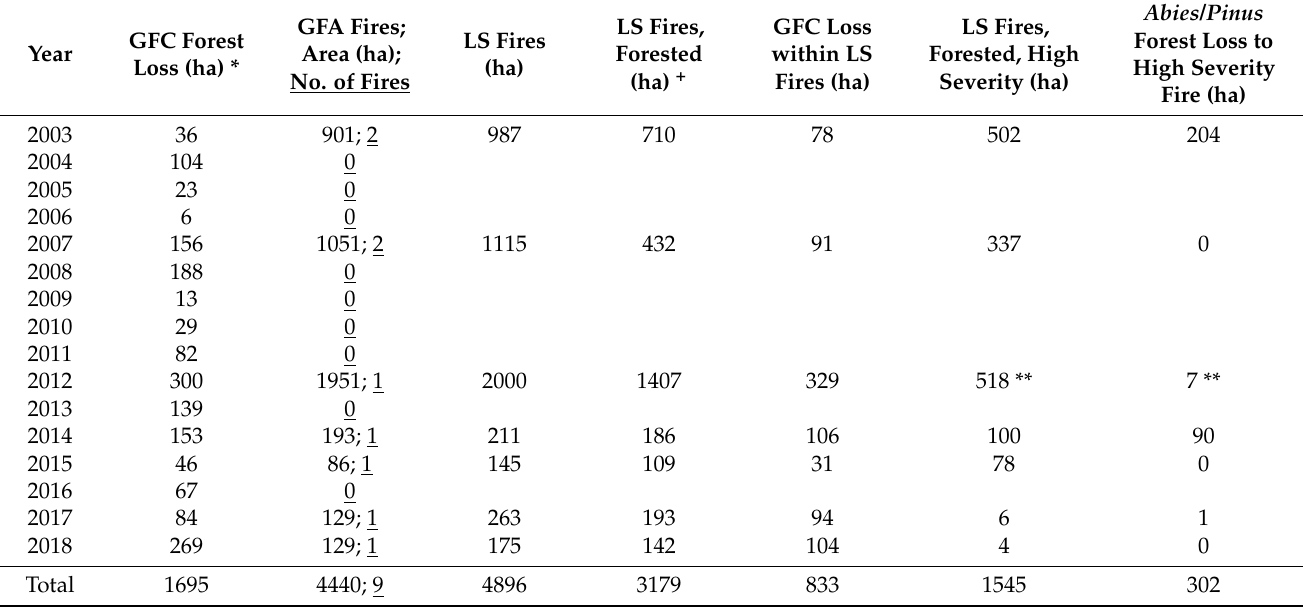
* Starting forest cover from GFC for TNP in 2003 was 38,570 ha. + Amount of forest contained within our digitized polygons, based on GFC, and therefore subject to loss by fire in a given year. ** Area adjusted for the proportion of the fire polygon covered by the evenly-spaced Landsat 7 ETM+ line failure data gaps (28%). We used the percentage of high-severity fire in the area outside of the data gaps to estimate the percentage of high-severity fire within the